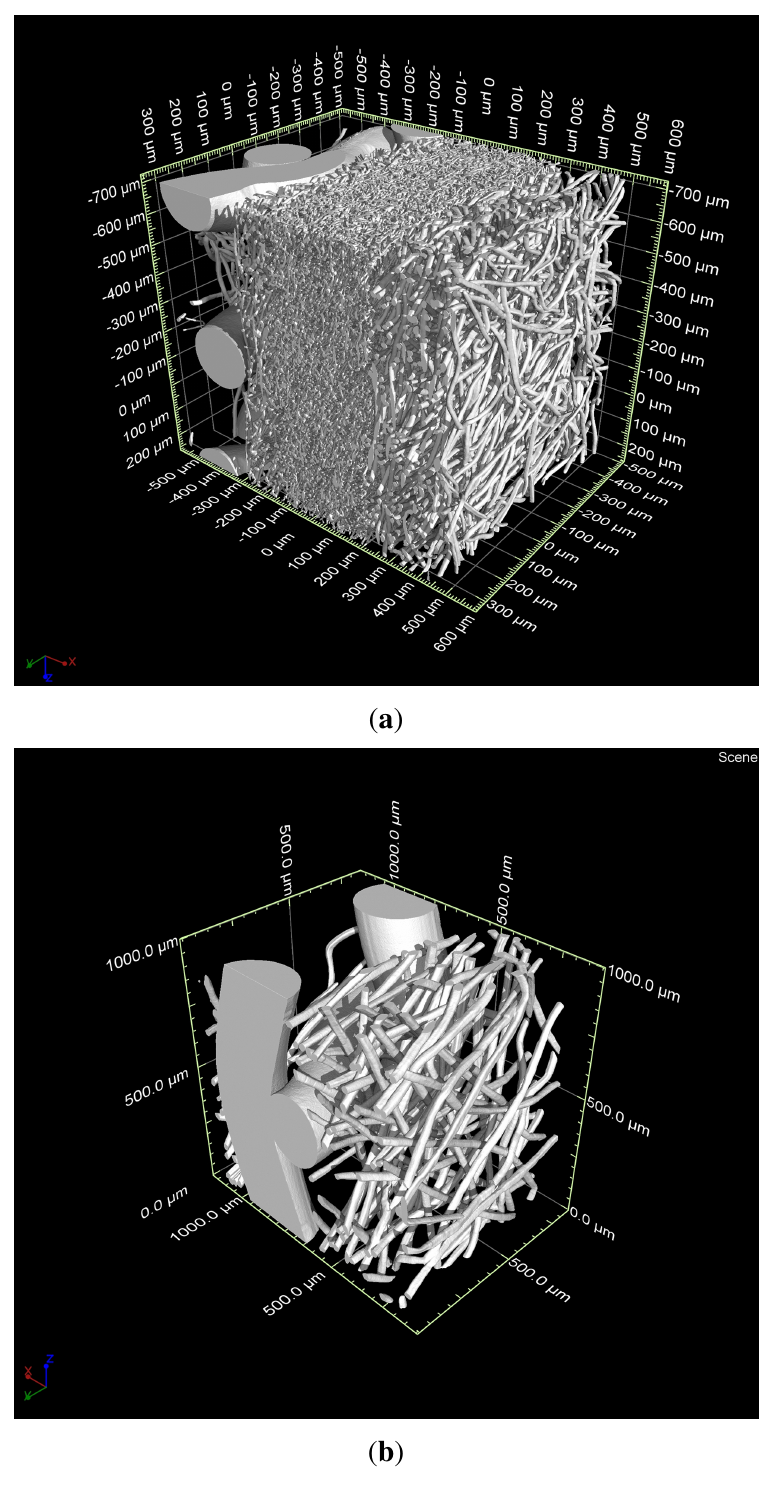
Figure 1. CT image of sintered fiber felts. ( a ) SFF 3; ( b ) SFF